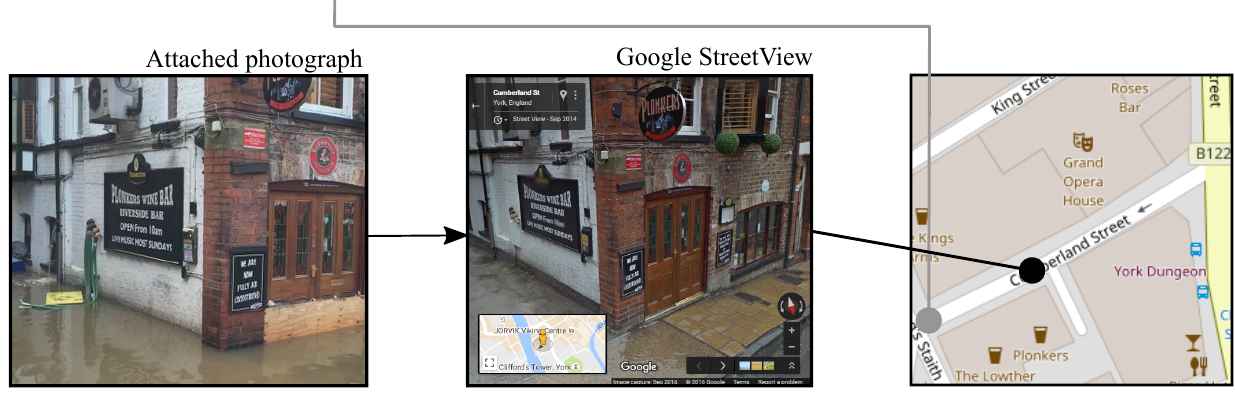
Figure 3. Example of determining the error in the spatial coordinates derived from the text of a tweet, based on an attached photograph. The grey dot is the location derived from the text of the tweet, and the black dot is the location derived from the attached photograph.